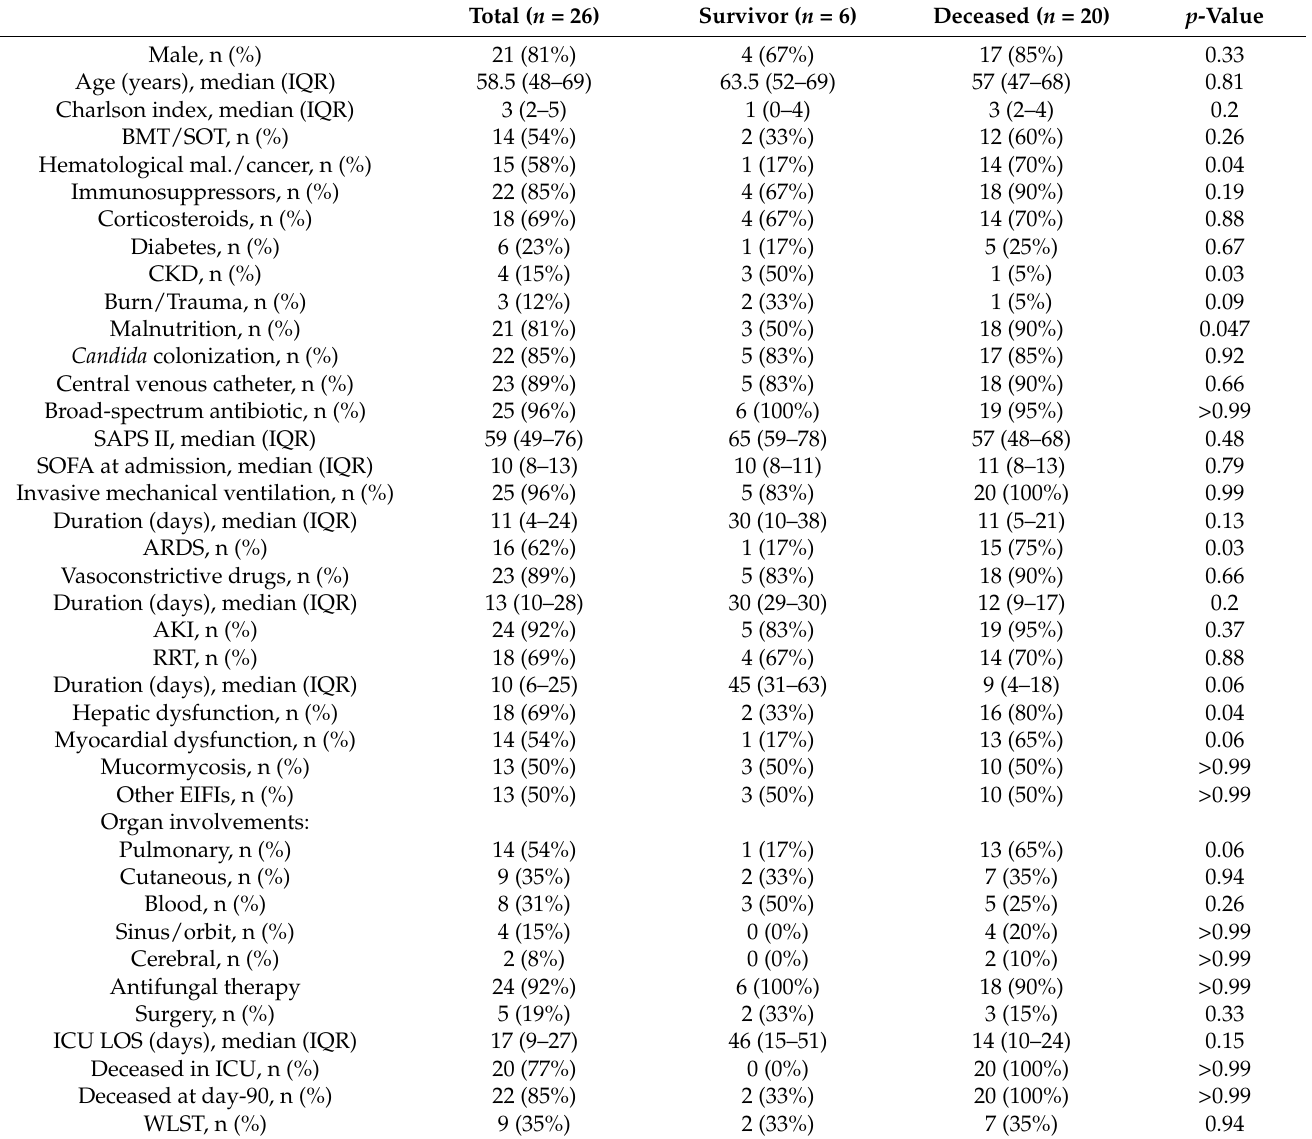
Characteristics of the study population are summarized in Table 1. Patients were mainly male (81%) with a median age of 59 (48–69) years old. All of them had one or more predisposing factors for EIFI, including drug-induced immunodepression (85%, induced by corticosteroids or immunosuppressive drugs), hematological malignancies, transplantation and malnutrition (81%). A majority of patients were previously treated with broad-spectrum antibiotics (96%), had a central venous access (89%) and were colonized with Candida (85%). Table 1. Characteristics of the study population and univariate analysis for in-ICU